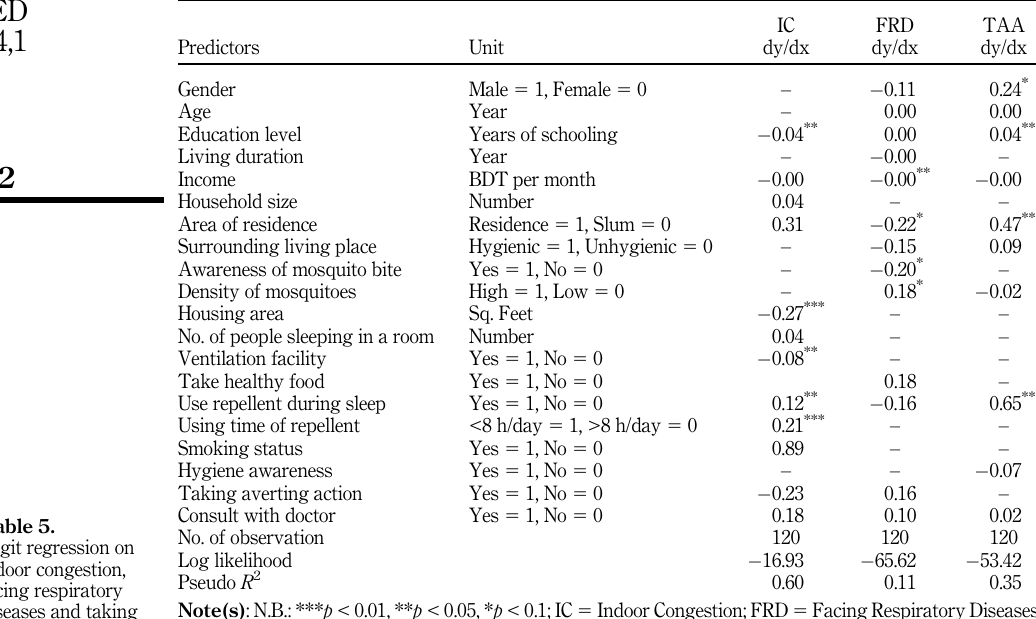
Table 5. Logit regression on indoor congestion, facing respiratory diseases and taking averting